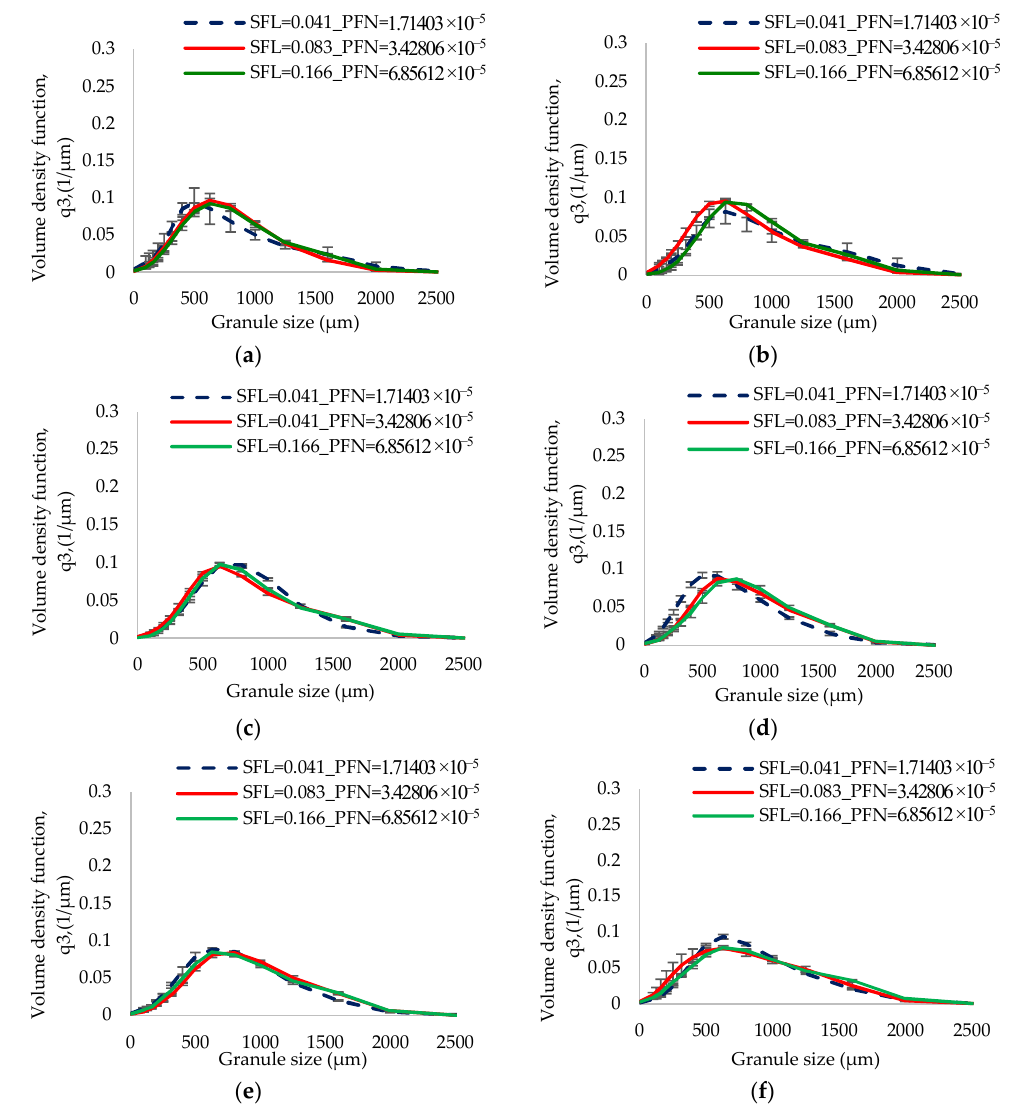
Figure 7. Granule size distribution of lactose (L/S 0.1) at different SFL–PFN at varying screw speed. ( a ) 150 rpm; ( b ) 250 rpm; ( c ) 400 rpm; ( d ) 500 rpm; ( e ) 750 rpm; and ( f ) 1000 rpm.